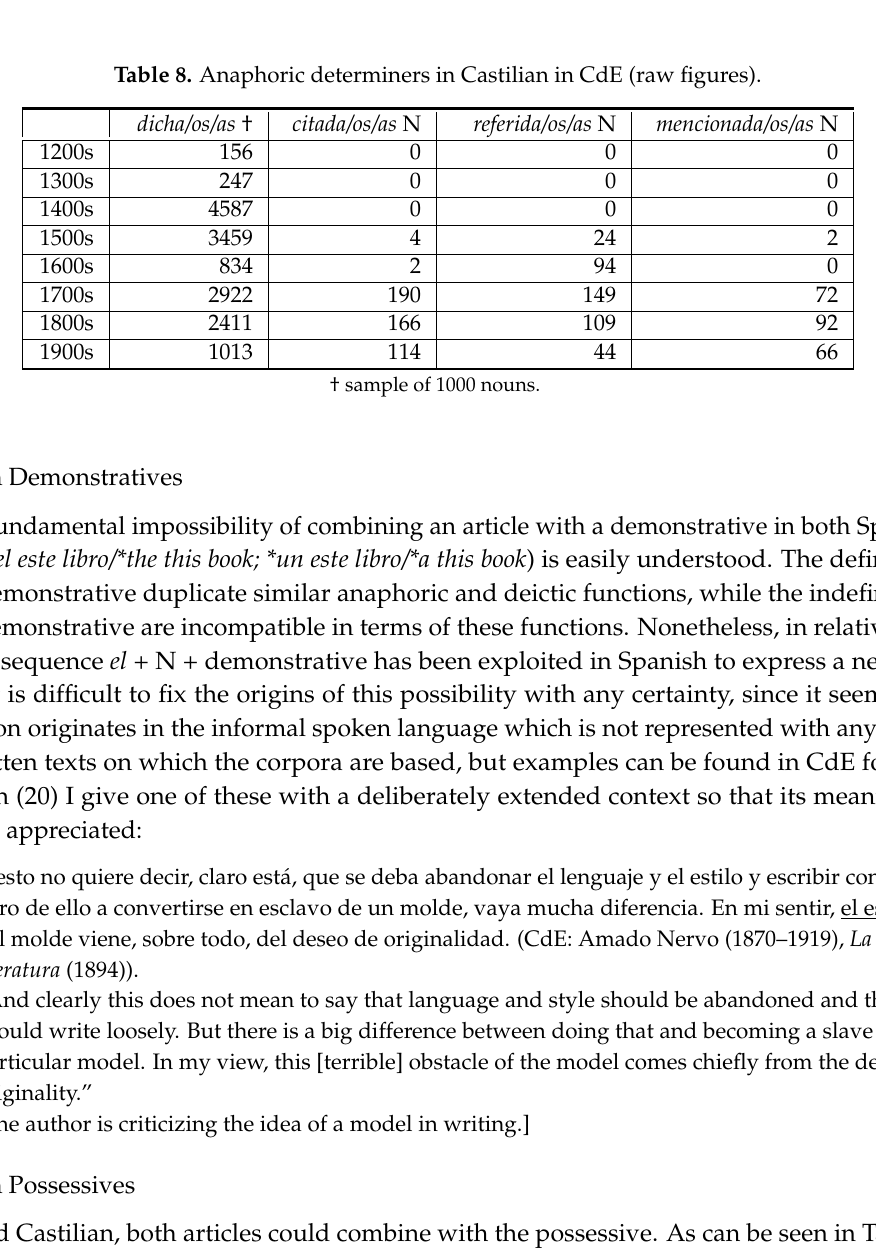
Table 8. Anaphoric determiners in Castilian in CdE (raw figures). dicha/os/as † citada/os/as N referida/os/as N mencionada/os/as N